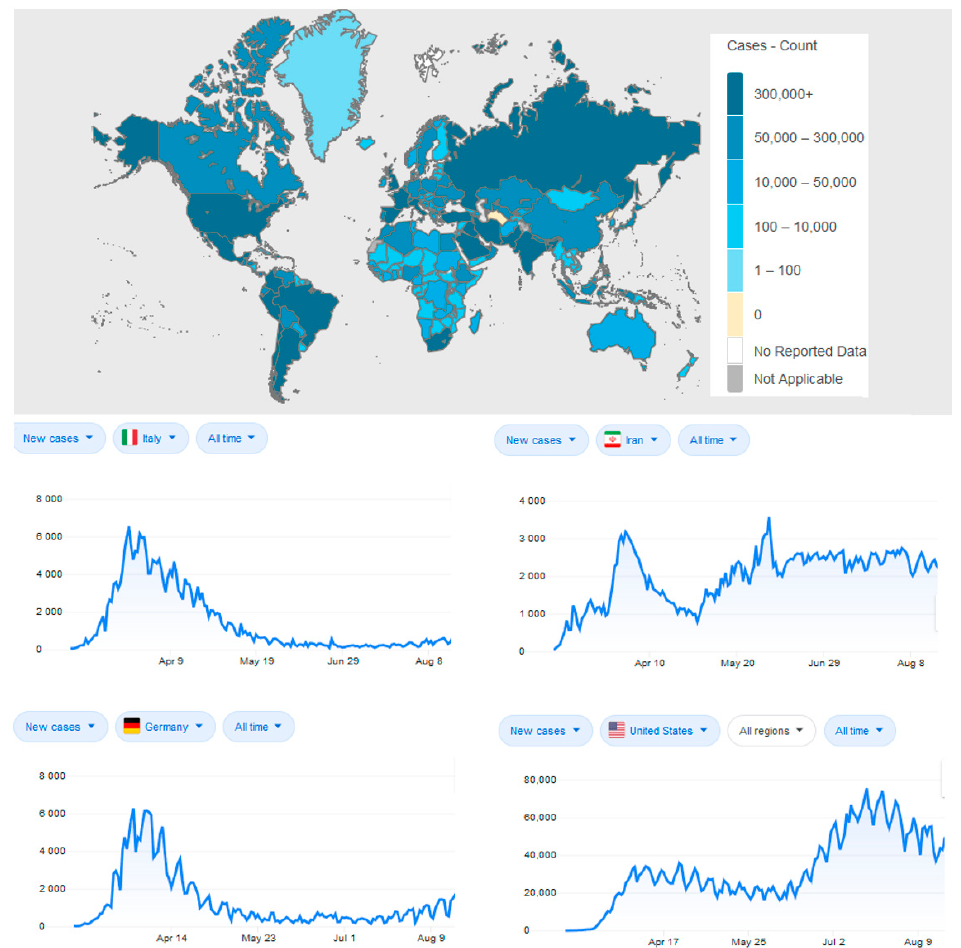
Figure 27. An overview of the current state of the COVID-19 outbreak including daily cases for the four countries of the study (source: World Health Organization).